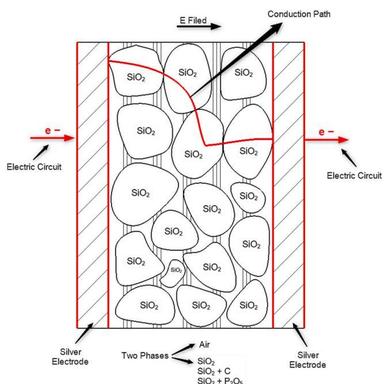
Illustration of the percolating effect phenomenon in the studied samples. The image shows the conduction mechanism between the particles.